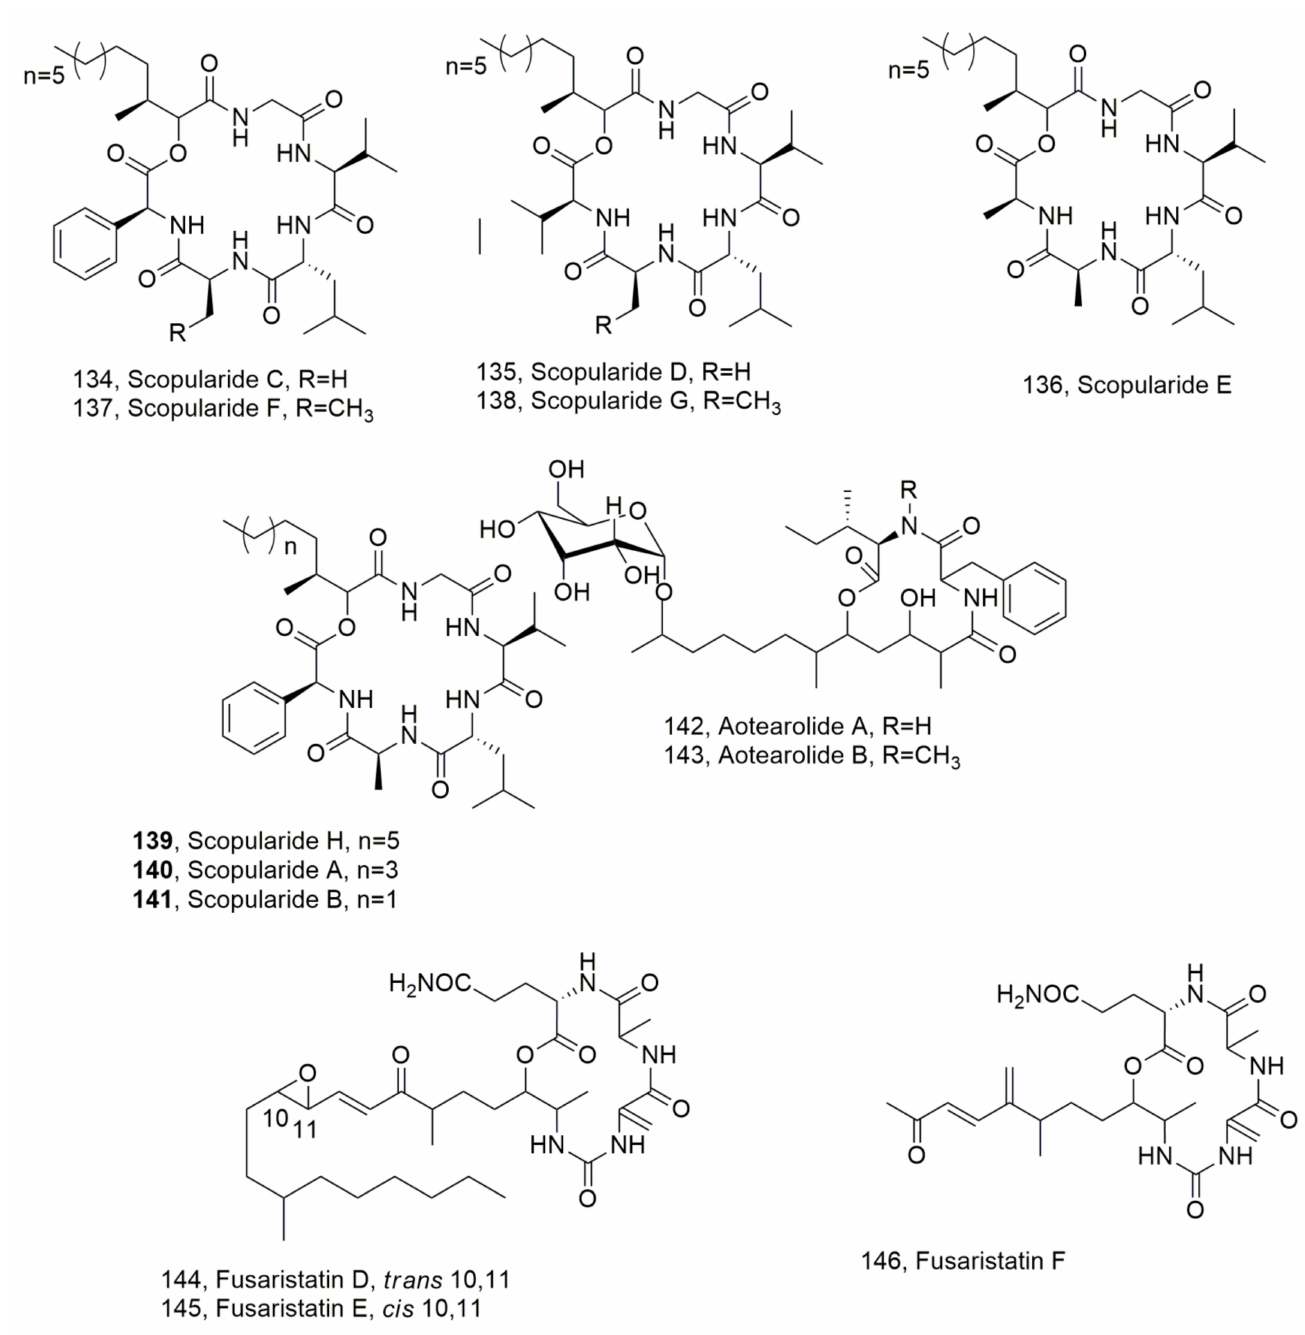
Figure 15. Structure of lipodepsipediteds produced by Beauvaria sp. ( 134 – 138 ), Scopulariopsis